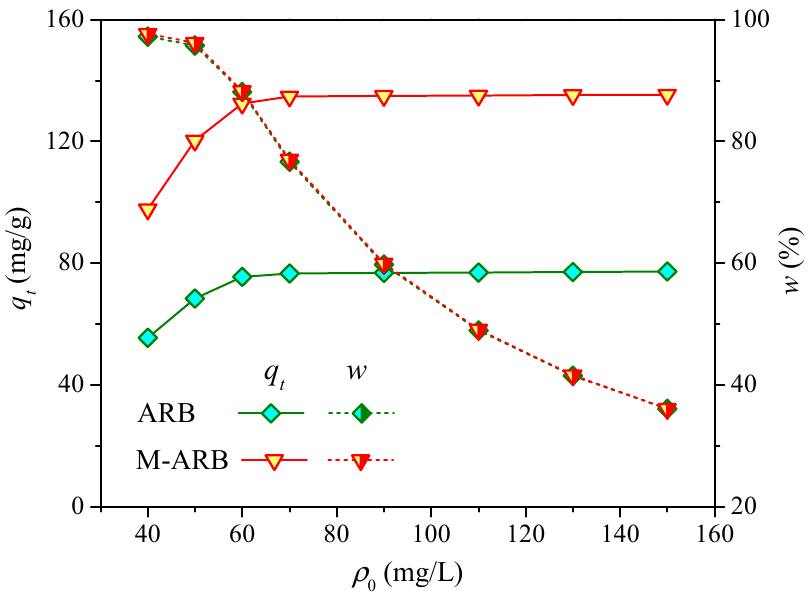
Figure 6. Effect of initial MB concentration on its adsorption performance.